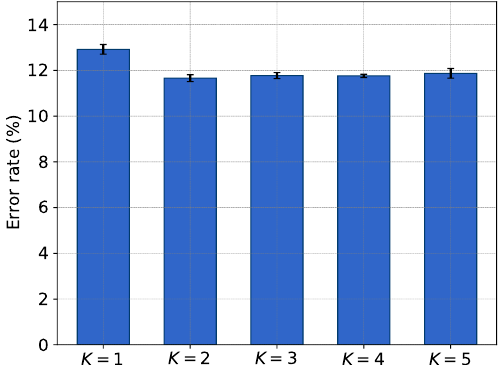
Figure 7. The error rate of Bi-Real+IE-BC with respect to a different number K of modified sign functions. The error rate is obtained by the difference between 1 and the accuracy rate on the CIFAR-10 dataset, and the lower error rate indicates better model